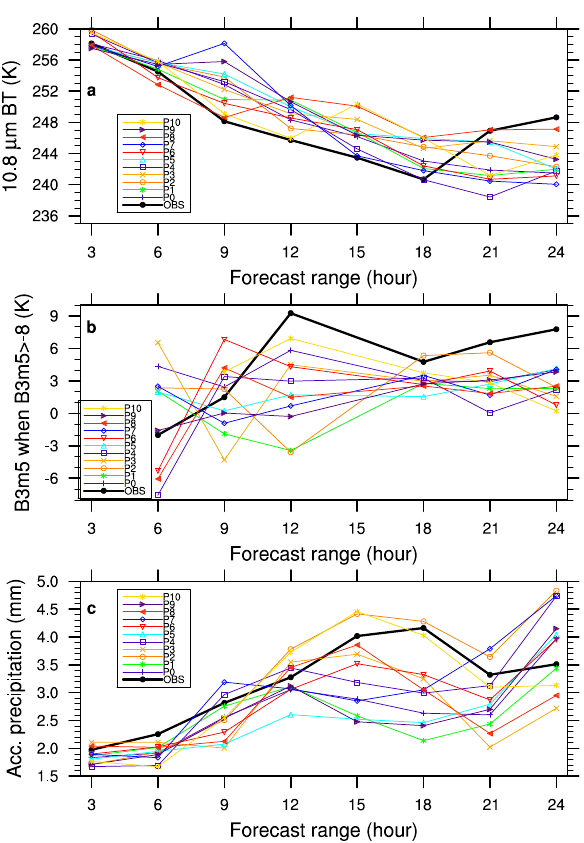
Fig. 9. Time series of mean (a) 10.8µm BT (K), (b) B3m5 (K) when B3m5 is larger than − 8 K, and (c) 3-h accumulated precipitation (mm). Fields were averaged over the domain shown in Fig. 8.